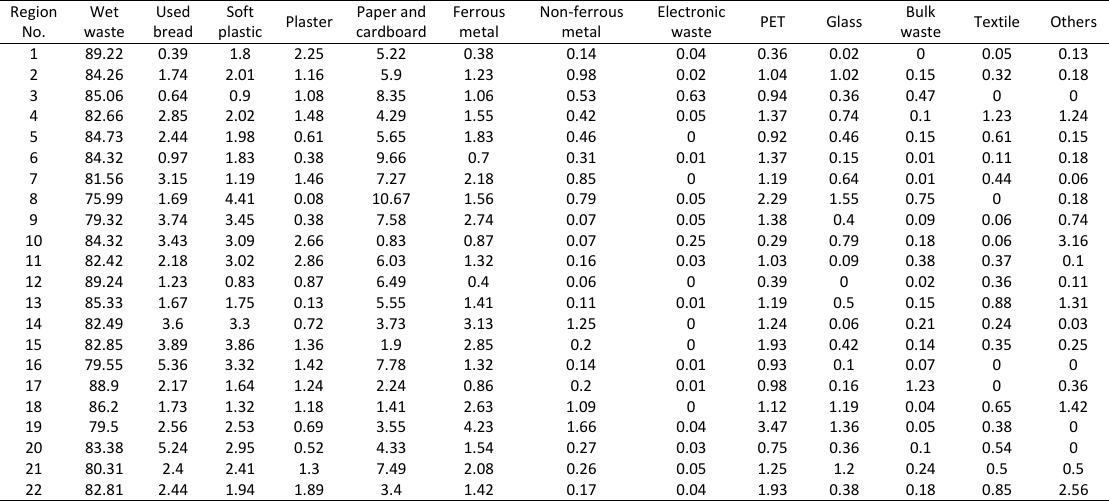
Table 3: Composition of MSW generated in Tehran in 2017 (%) (TWMO, 2018) Table 3. Composition of MSW generated in Tehran in 2017 (%) (TWMO, 2018) Region Wet Used Soft Paper and Plaster No. waste bread plastic cardboard